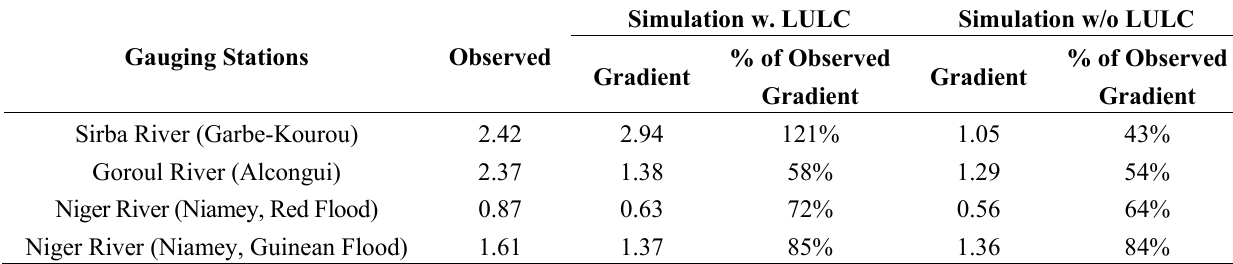
Table 3. Gradient of the trends of AMAX anomalies (see Figure 4) as estimated with the Theil-Sen